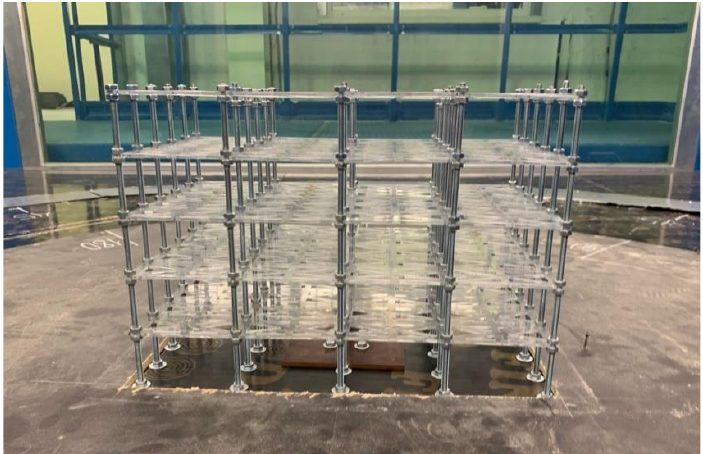
Figure 3. Aeroelastic model of an industrial tower-type supporting frame.